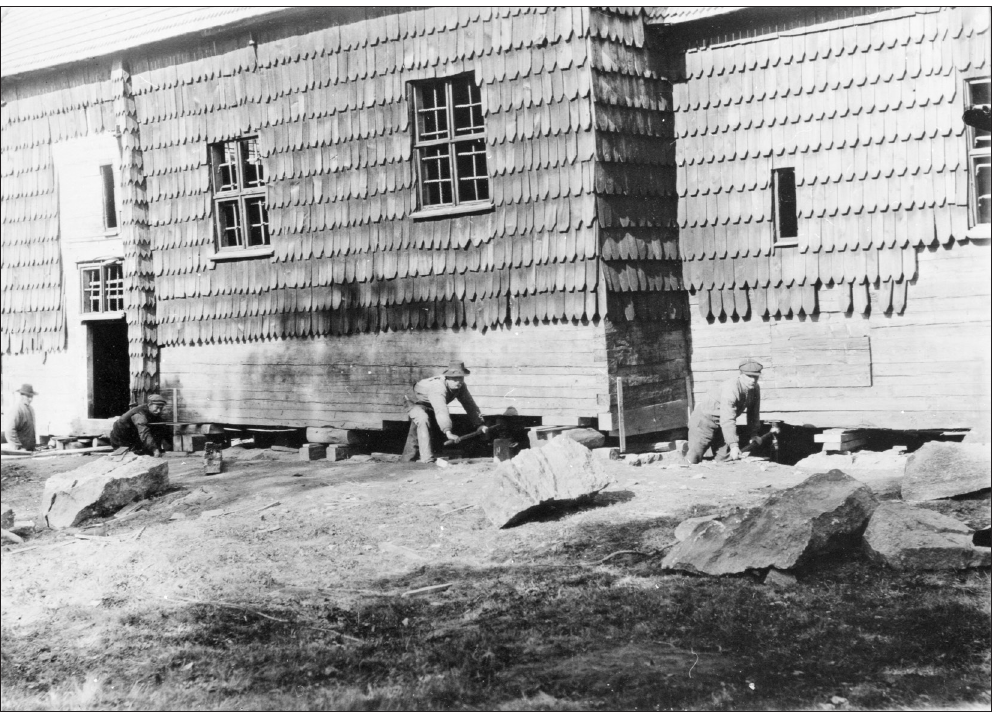
Figure 2: The church of Södra Råda was restored at several times around the turn of the century 1900. Here, the original southern entrance has been uncovered and the craftsmen are lifting the timber structure to replace the sill. (Photographer and year unknown. Source: Swedish National Heritage Board. Photo id. 3180-020. Public